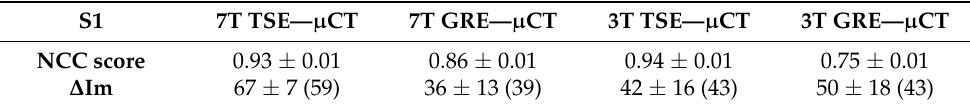
Table 2. S1 normalized cross-correlation (NCC) scores and ∆ Im, the number between two consec- utive best registered µ CT images used to evaluate the registration efficiency for the four stacks of MRI